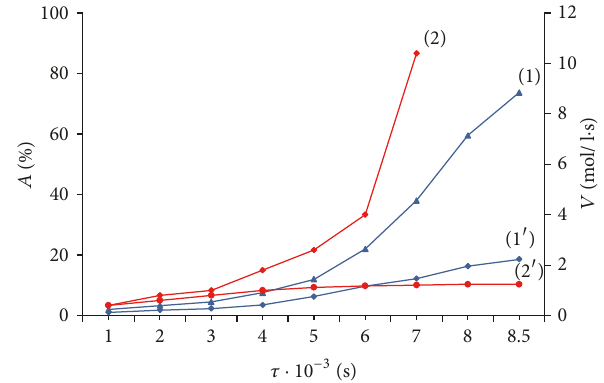
Figure 1: Degree and rate of emulsion polymerization of vinyl monomers in the presence of PVP: (1) , (1 󸀠 ) – 0 ; (2) , (2 󸀠 ) – V . (1) , (2) VV0 . (1 󸀠 ) , (2 󸀠 ) styrene. 𝐶 = 0.99 mol/l; 𝐶 = 2.81 ⋅ 10 −3 mol/l; mon . in . 𝐶 = 0,09 mol/l; 𝑀 = 28000; 𝑇 = 323 K. PVP PVP